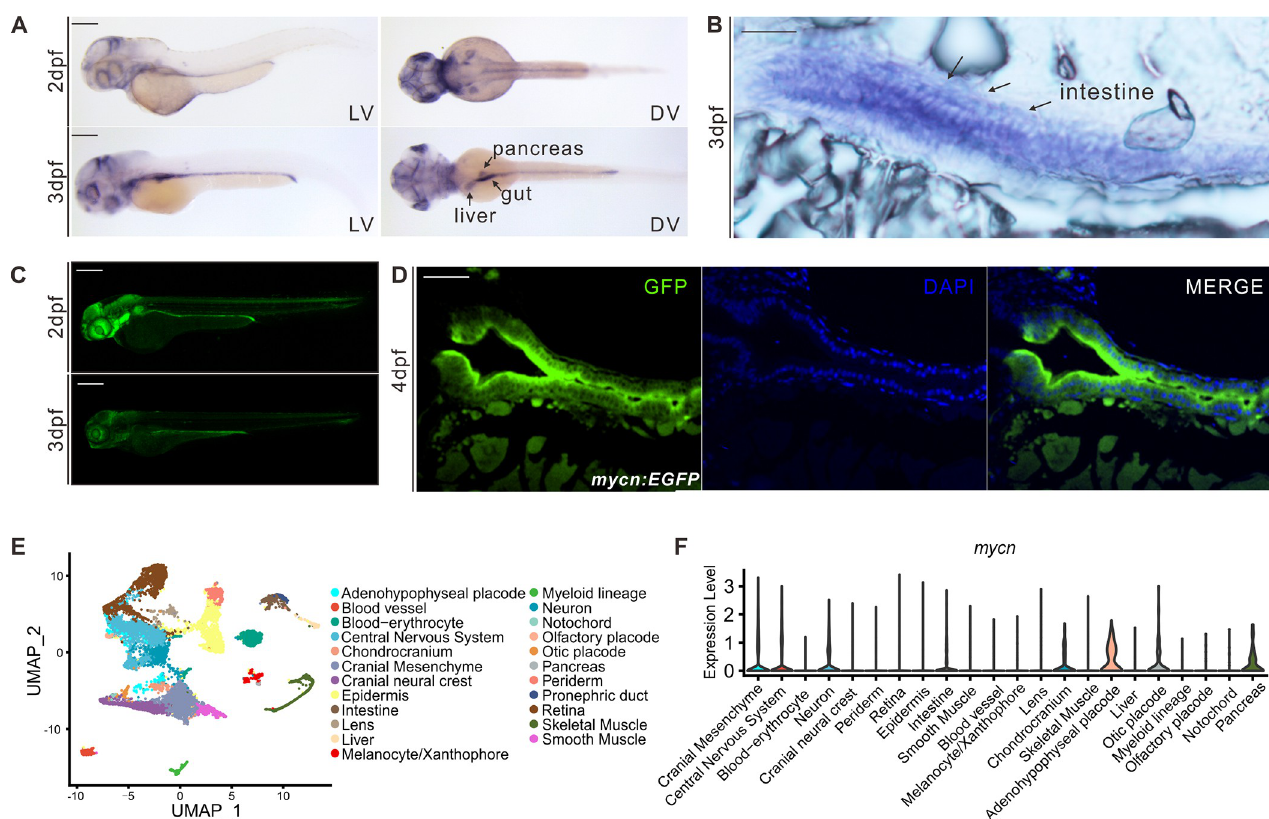
Fig 1. mycn expression patterns in zebrafish during early development. (A) Expression patterns of mycn in zebrafish at 2 and 3 dpf by whole-mount WISH. Lateral view (left), dorsal view (right). (B) mycn expressed along the whole intestines of the embryos at 3 dpf shown by section via ISH. Arrows indicate the embryo intestines. Sections were cut along the sagittal plane. (C) Fluorescence images show the mycn expression patterns by EGFP-knock-in fish at 2 and 3 dpf (lateral view). (D) mycn expressed along the whole intestines of the zebrafish at 4 dpf shown by section of mycn : EGFP fish. (E) UMAP plot shows unsupervised clustering of the cells in WT embryos of 3 dpf; cells are colored by their cell type annotations. (F) Violin plots show the mycn expression levels of different cell types of WT embryonic scRNA-seq data at 3 dpf. Scale bars: 200 μ m ( A and C ), 50 μ m ( B and D ). dpf, days postfertilization; ISH, in situ hybridization; scRNA- seq, singe-cell RNA-seq; UMAP, uniform manifold approximation and projection; WISH, whole mount in situ hybridization; WT, wild-type.